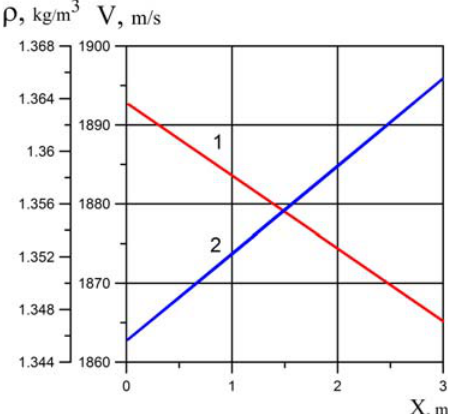
Figure 5 – Calculated dependence of the velocity V (1) and density ρ (2) along the length of the tubular guide at the moment the projectile leaves the guide (the flow moves from left to